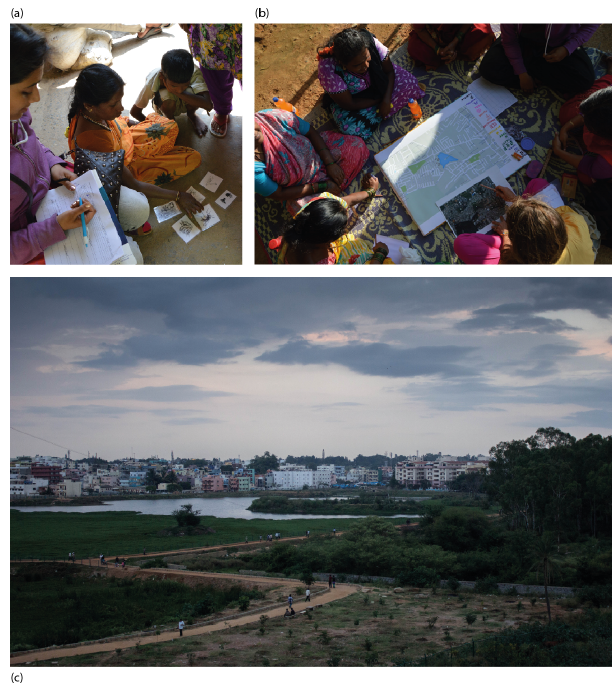
Fig. 2 . Impression of a household interview (a), group mapping session (b), and lake area